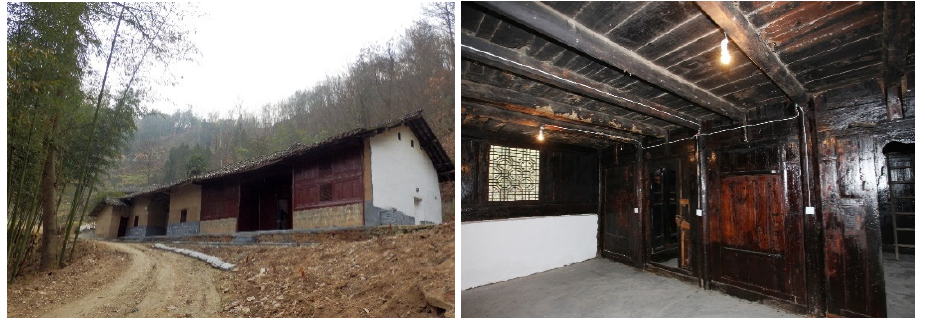
Figure 2. Photos of folk houses in southern Shaanxi.